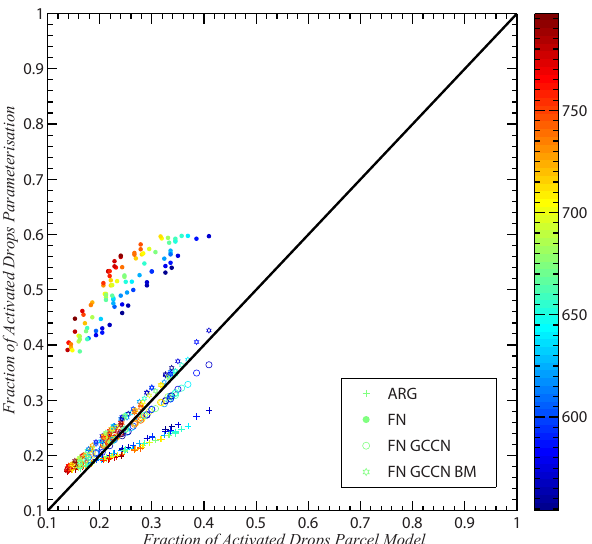
Figure 5. Results for peak RH from 1500 runs with bimodal aerosol size distributions. Only the median diameter of the aerosol in the second mode and updraft velocity were changed between runs within the ranges of 100 ≤ d m ≤ 800nm and 0.2 ≤ w ≤ 5ms − 1 re- spectively. Symbols are coloured by updraft velocity, see colour bar. For initial conditions see Table